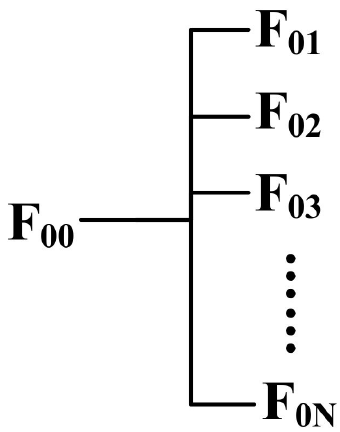
Figure 3. Structure diagram of MSS fault